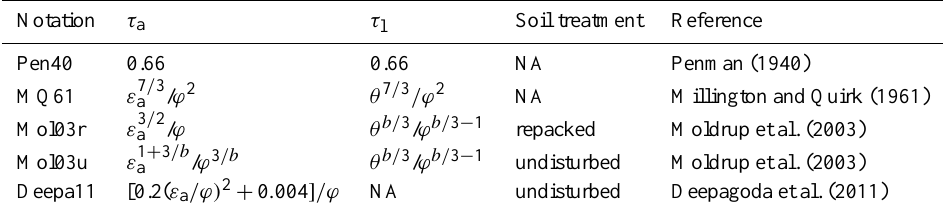
Table 1. Summary of tortuosity factor formulations for gaseous ( τ a ) and liquid ( τ l ) diffusion from the literature. ε a : air porosity; ϕ : total porosity; θ : soil water content; b : pore-size distribution parameter; NA: data not available.